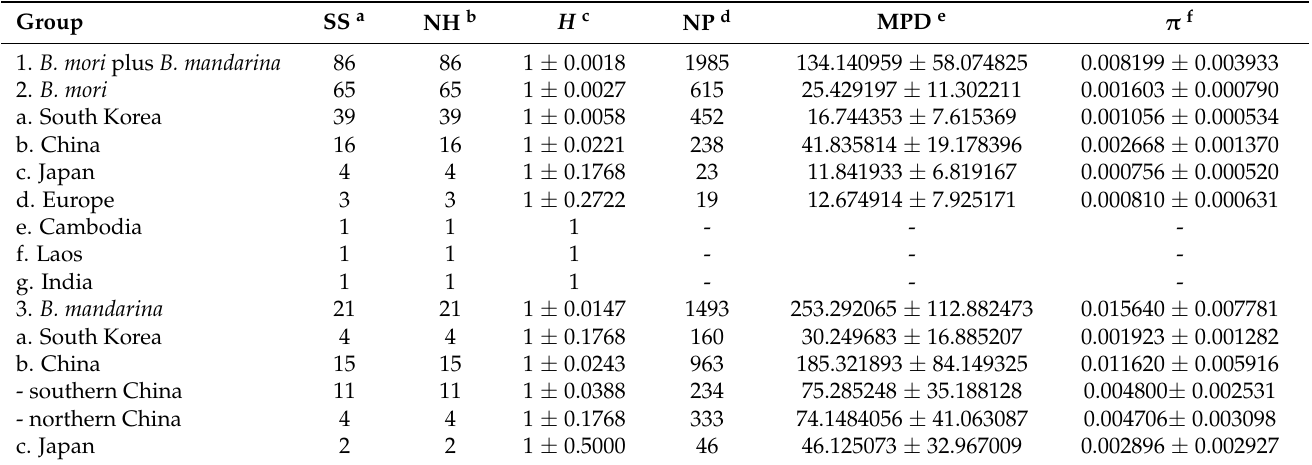
Table 1. Genetic diversity